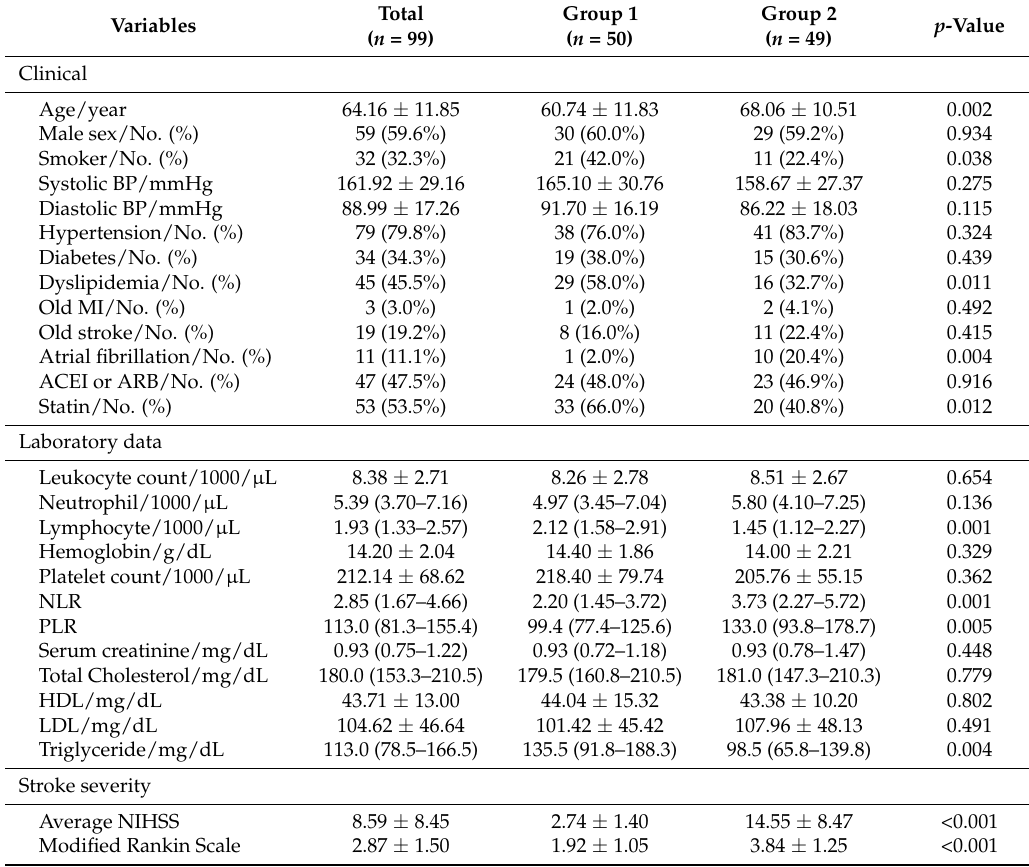
Table 1. Baseline characteristics of the stroke patients between Groups 1 (NIHSS <6) and 2 (NIHSS ≥